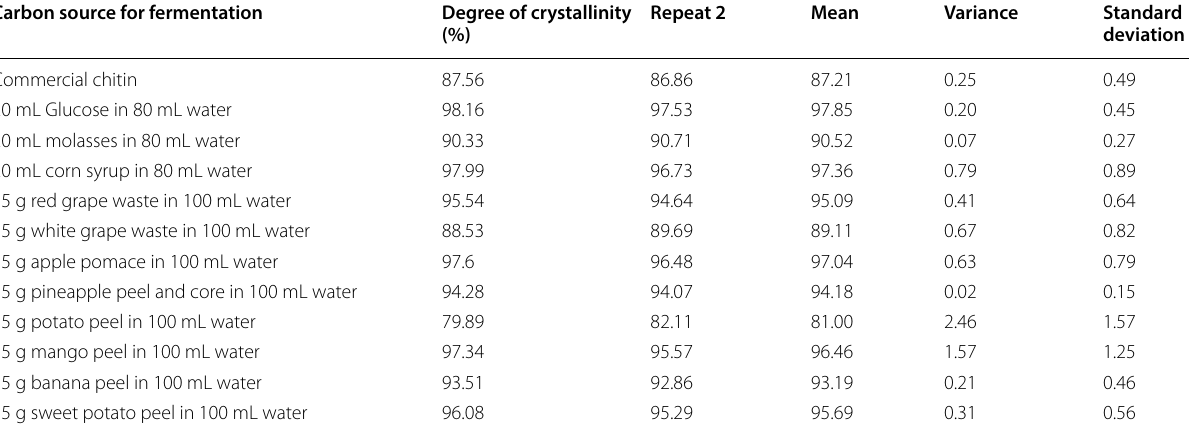
Table 8 Statistical analysis of degree of crystallinity of chitin extracted after fermentation on various carbon sources Carbon source for